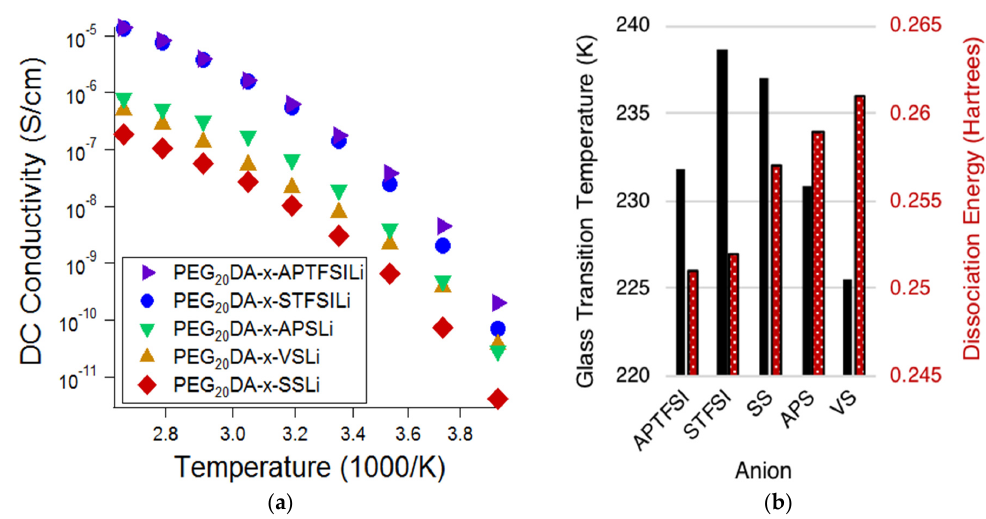
Figure 2. ( a ) DC conductivity from − 20 to 100 °C for electrolytes containing the five different anions, and ( b ) corresponding experimental T g values for these electrolytes and DFT calculated dissociation energies for ion pairs ALi, where A is the anion on the y ‐ axis.